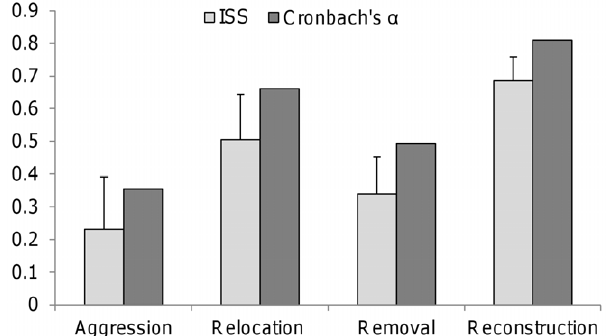
Figure 3. Consistency values (ISS; bright grey, left) of the two behavioral trials for each of the four behaviors measured (means ± 1 SE), and Cronbach’s a coefficients of reliability tests (dark grey, right). High values represent a higher consistency level.